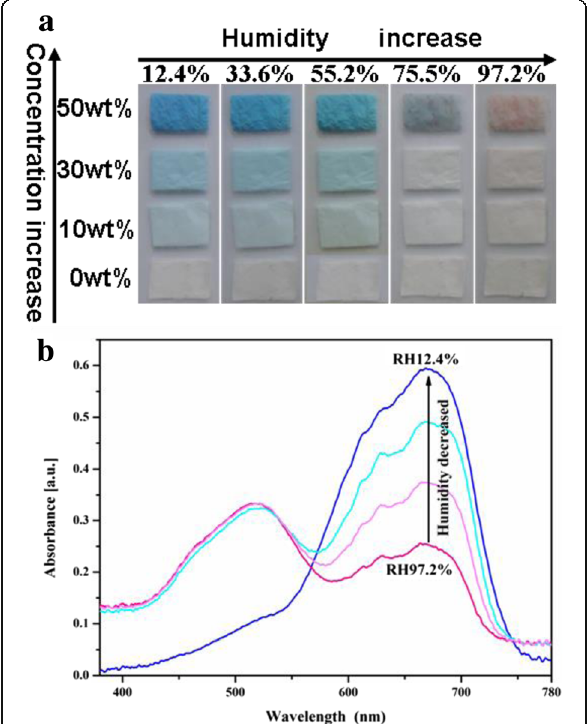
Fig. 2 a The photographs of PA66/CoCl 2 ·6H 2 O NFMs containing different concentrations of CoCl 2 ·6H 2 O: 0, 10, 30, and 50 wt% in different RH. b Humidity dependence of visible absorption spectra